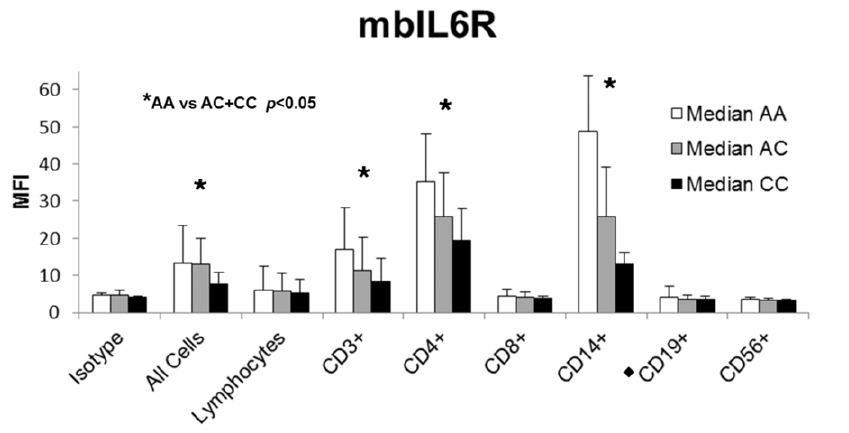
Figure 2. mbIL6R levels. Levels of mbIL6R for CD patients (n=58) and HD (n=50) were measured by flow cytometry. Subjects who are homozygous for the major allele exhibit the highest levels of mbIL6R (white). Levels are decreased at the cell surface of heterozygous subjects (grey) and lowest on minor allele-homozygous subjects (black). Reductions were significant on a subset of T cells and monocytes. CD19 data is omitted from 5 patients who received rituximab (black diamond). MFI: median fluorescence